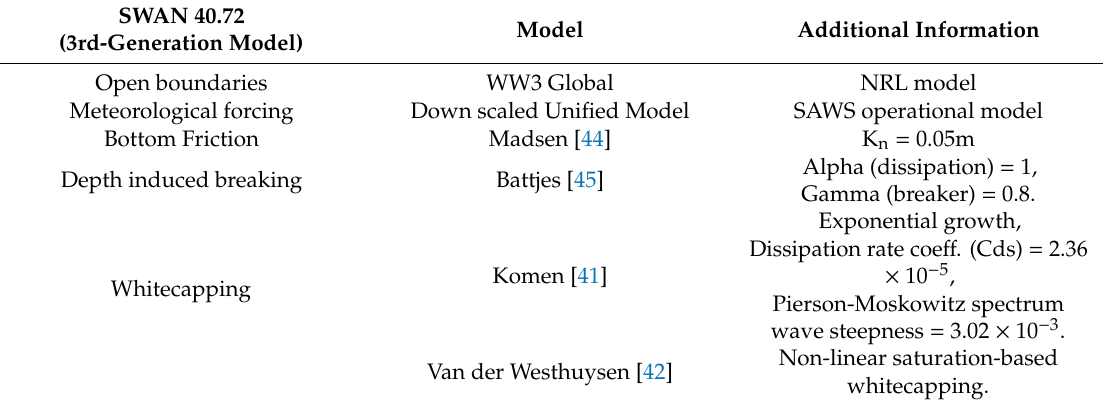
Table 2. Summary of physical parametrization setting for SWAN 40.72, used in the present